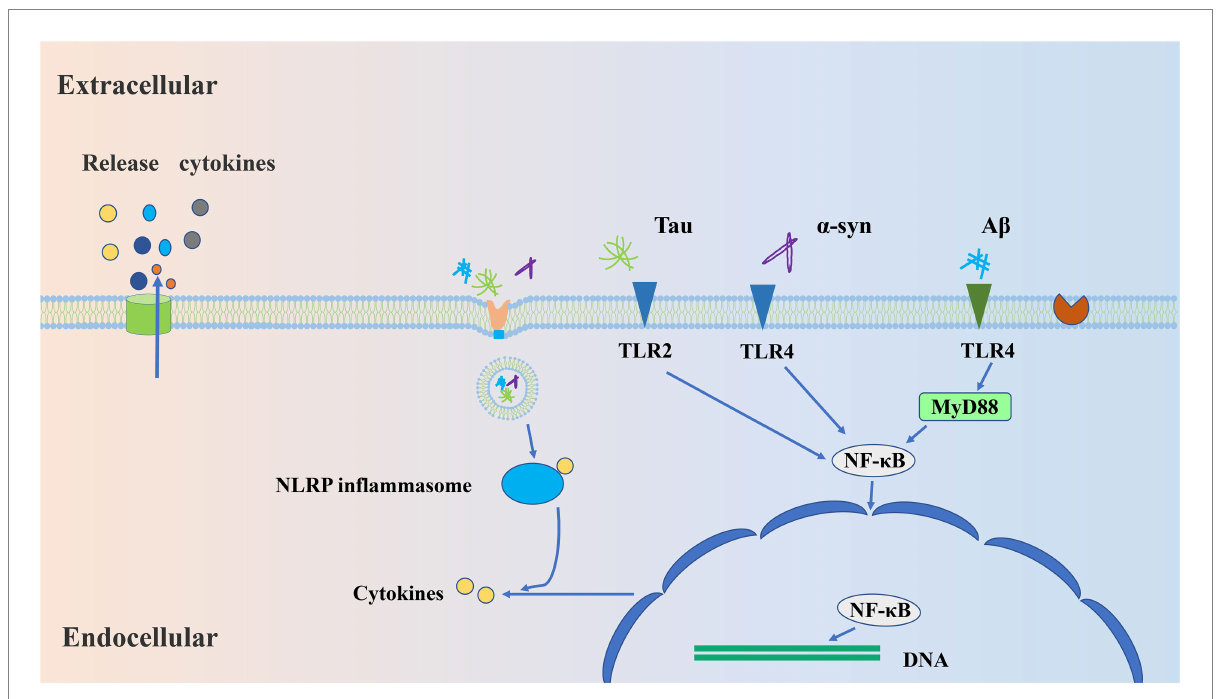
FIGURE 1 The mechanisms by which microglia respond to aggregated proteins. Firstly, aggregates (A β /Tau/ α -syn) are recognized by microglial pattern recognition receptors, such as TLR2 and TLR4. Afterward, these receptor binding activates the specific signaling pathways involving MYD88/NF- κ B, which leads to transcription of NLRP3 and subsequent enables the release of inflammatory cytokines, namely IL-18 and IL- β . Further, the release of cytokines will induce chronic inflammatory